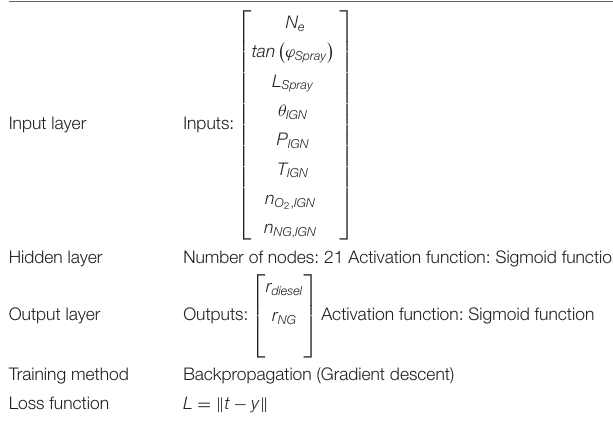
TABLE 3 | Details of the neural network for prediction of parameters in the Wiebe function.